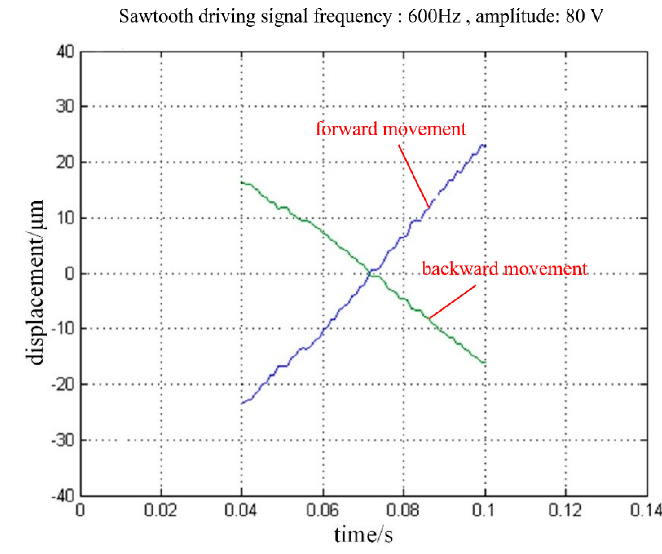
Figure 12. Forward and backward displacements of the PASSNS under the driving signal.